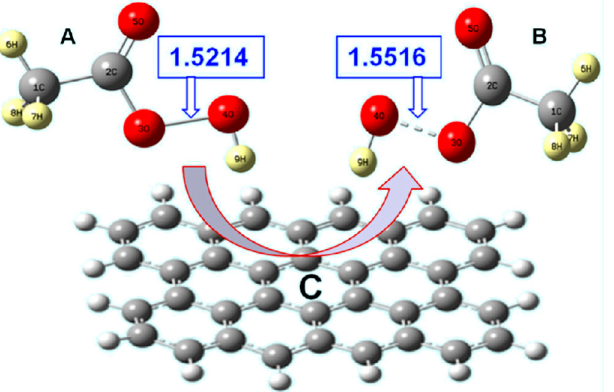
Figure 4. Mechanism of activated carbon catalyzed PAA. Reprinted with permission from Ref.